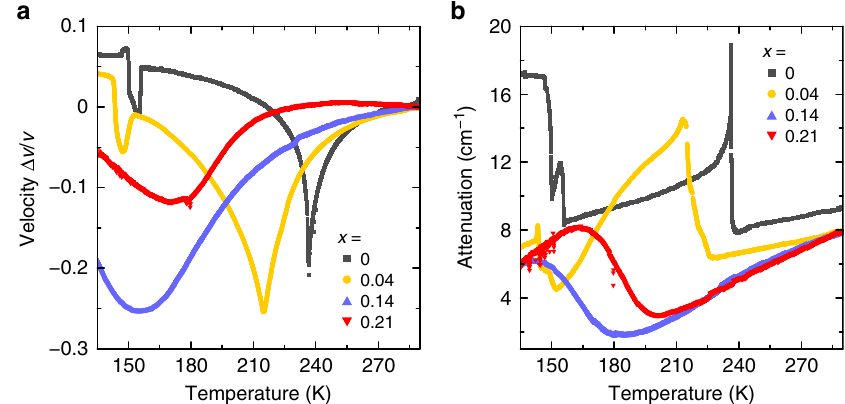
Fig. 2 Ultrasonic properties of mixed MA 1 − x DMA x PbBr 3 perovskites. a Ultrasonic velocity and b attenuation of the x = 0, 0.04, 0.14, and 0.21 single crystal compounds measured on cooling. The change of the ultrasonic velocity is normalized to the room temperature